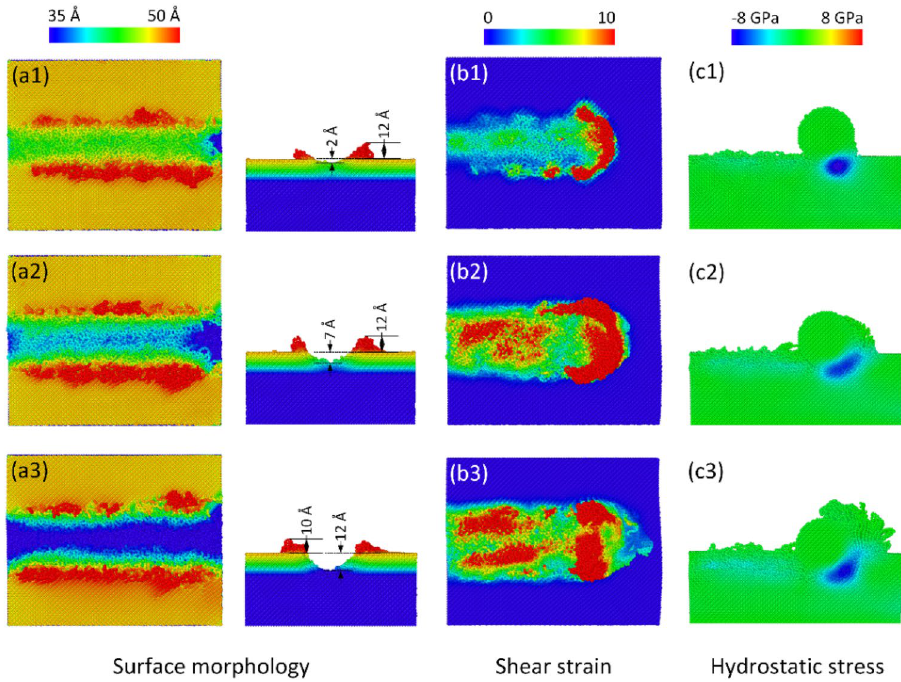
Figure 2. Surface morphology, shear strain and hydrostatic stress distributions of different depths at 300 K, 100 m/s: ( a1 , c1 ) 5 Å, ( a2 , c2 ) 10 Å, and ( a3 , c3 ) 15